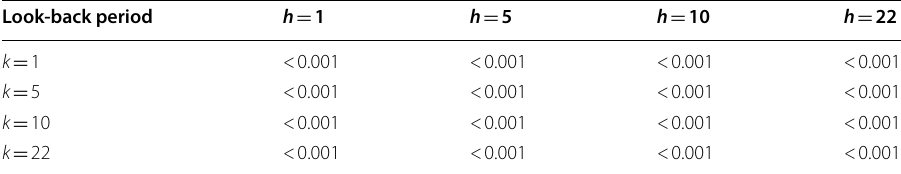
Table 3 Testing results of the momentum of jumps